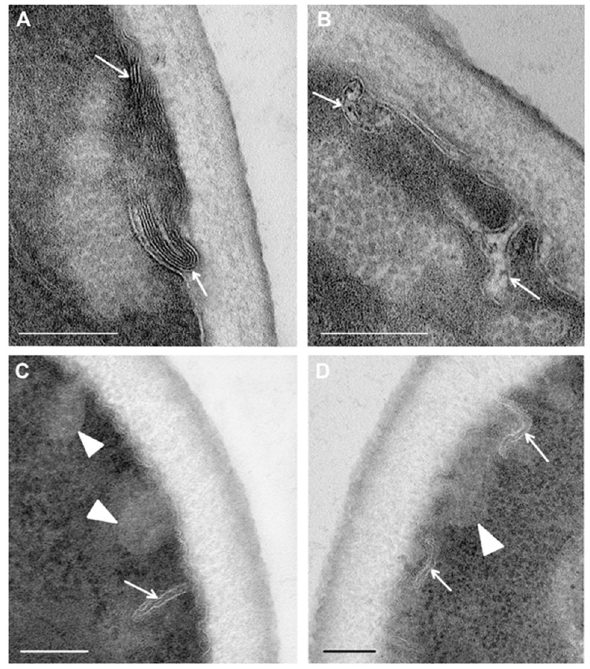
Figure 7. Changes in the ultrastructure of the plasma membrane of C. albicans cells incubated for 30 min with the R9F2 peptide. ( A ) a multilayer structure (shown by arrows) formed by the plasma membrane; branched ( B ) and narrow ( C , D ) invaginations of the plasma membrane extending into the cytoplasm (shown by arrows). Clusters of thin-membrane structures resembling foam (shown by the arrowhead). ( C , D ) sections without staining. Scale bars correspond to 200 nm.